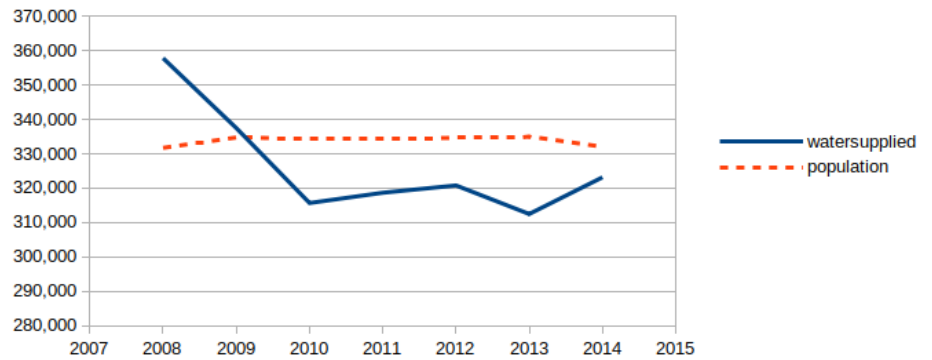
Figure 6. Supplied water and population of the zone 4.1. from 2008 to